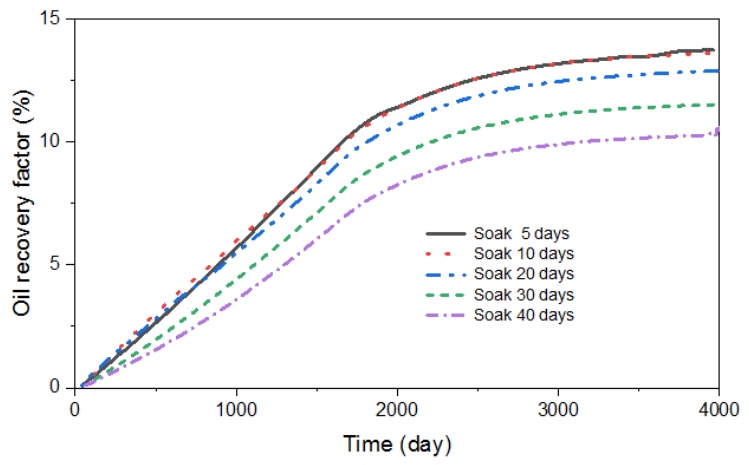
Figure 11. The comparison of oil recoveries under different soaking times.